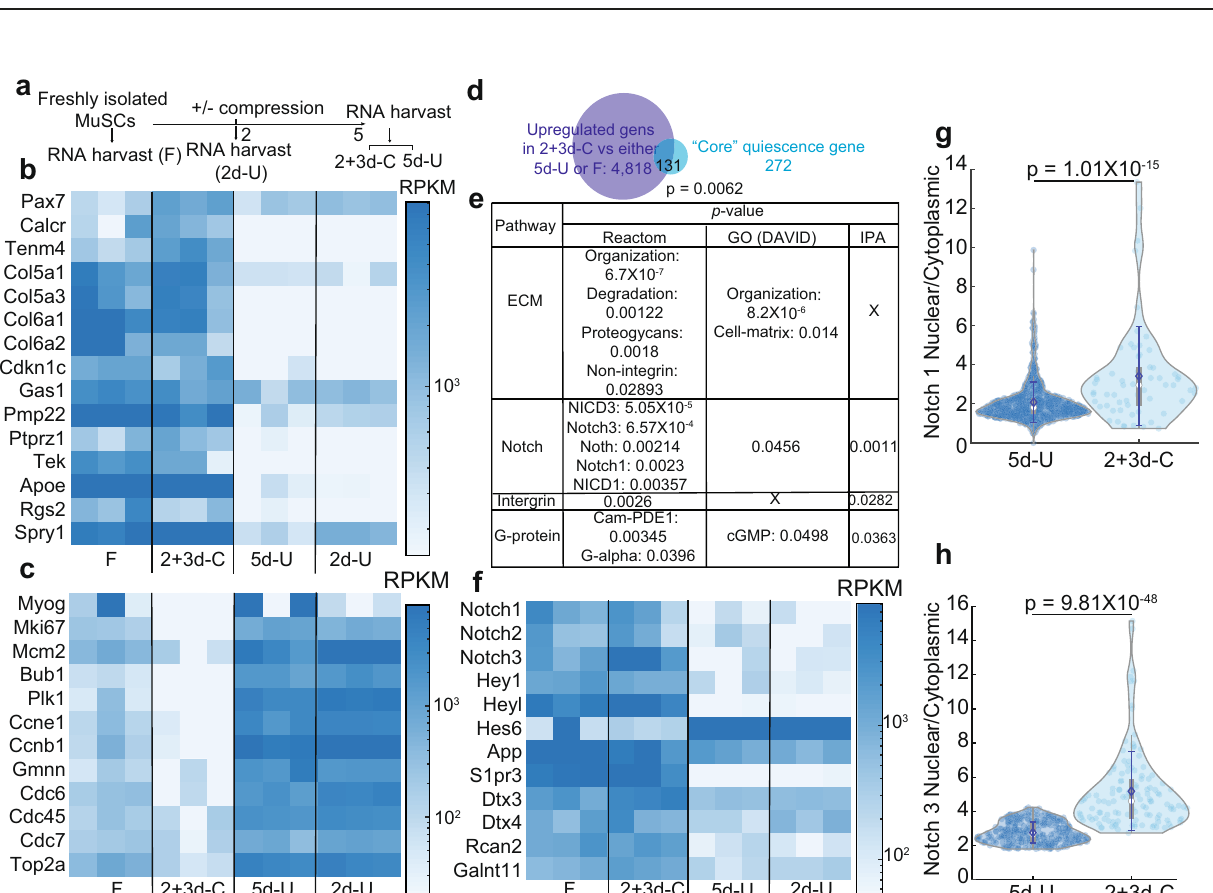
Fig. 2 Tension analysis for MuSCs under different conditions. a Mathematical model prediction of change in average tension distribution in terms of compressive strain. b and c pMLC distribution of 5d-U and 2 + 3d-C cells. This is in terms of overall pMLC ( b ) and pMLC Edge/Center ratio ( c ) ( n = 3 for